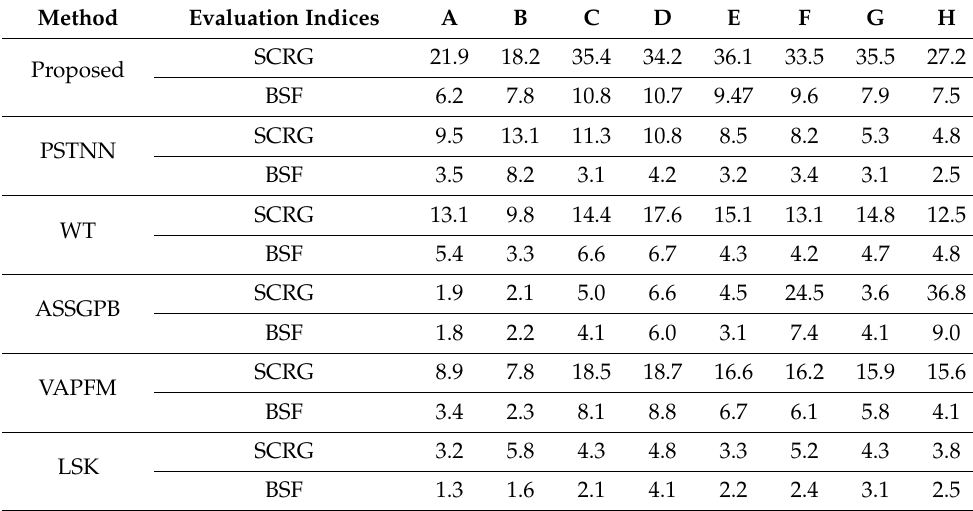
Table 2. Evaluation indices comparison of SCRG,